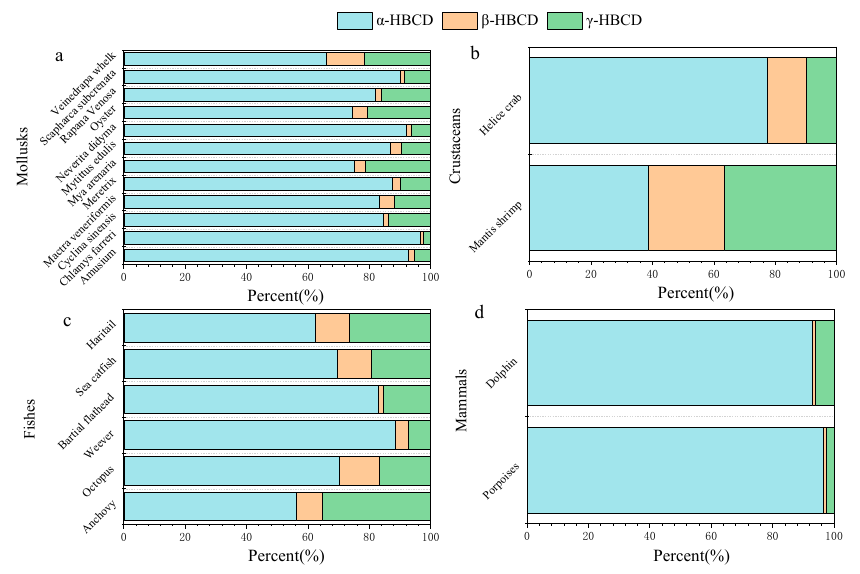
Figure 1. Diastereoisomer patterns of HBCDs in marine biota from China. ( a ) mollusks; ( b ) crustaceans; ( c ) fishes; ( d ) mammals.